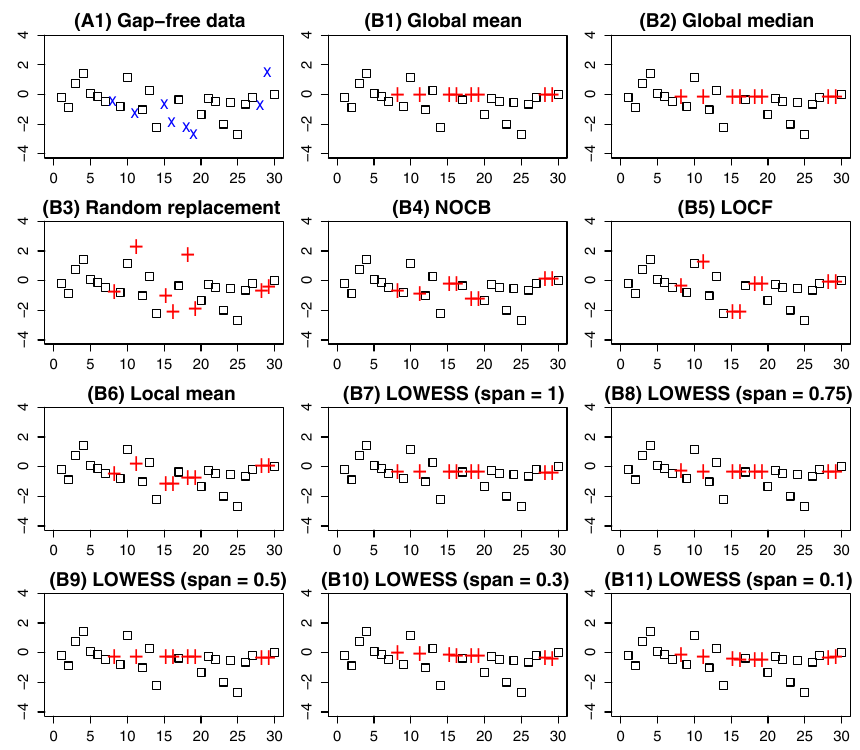
Figure 4. Illustration of the interpolation methods for gap filling. The gap-free data (A1) was simulated with a series length of 500, with the first 30 data shown. ( × : omitted data for gap filling; + : interpolated data; NOCB: next observation carried backward; LOCF: last observation carried forward; LOWESS: locally weighted scatterplot